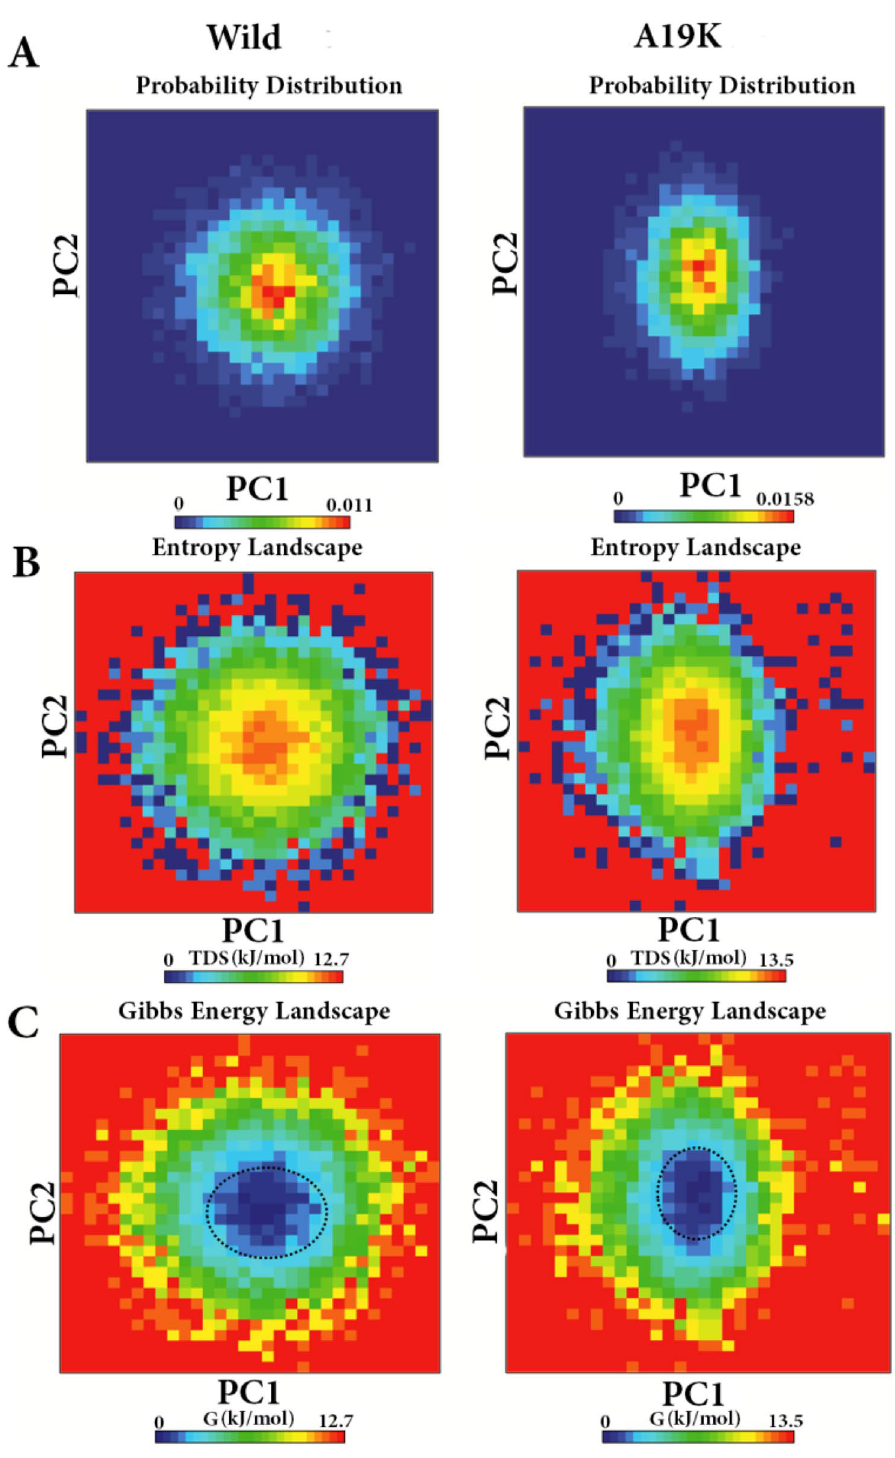
Figure 6. Probability distribution modification of the first two eigenvectors and fluctuation and free energy landscape of the WT and p.A19K forms of the Brazzein /hTLR5 complex. ( A ) Probability distribution modification of the first two eigenvectors and fluctuation of the WT and p.A19K forms. The dark blue and red colors indicate the lowest and the highest probability motions, respectively. ( B ) The entropy of the structure of the WT complex in comparison with the mutant forms. ( C ) Free energy landscape for the WT and p.A19K forms of the